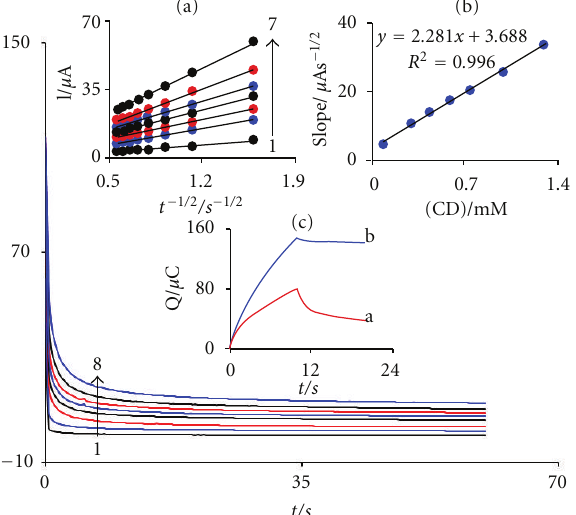
Figure 4: Chronoamperograms obtained at FCDCNPE in 0.1 M PBS (pH 5.0) for di ff erent concentrations of CD. The numbers 1– 8 correspond to 0.0, 0.3, 0.1, 0.45, 0.6, 0.75, 1.0, and 1.3mM of CD. Insets: (a) plots of I versus t − 1 / 2 obtained from chronoamper- ograms 2–8. (b) Plot of the slope of the straight lines against CD concentration and (c) FCDCNPE chronocolougrams in the absence (a) and presence of CD